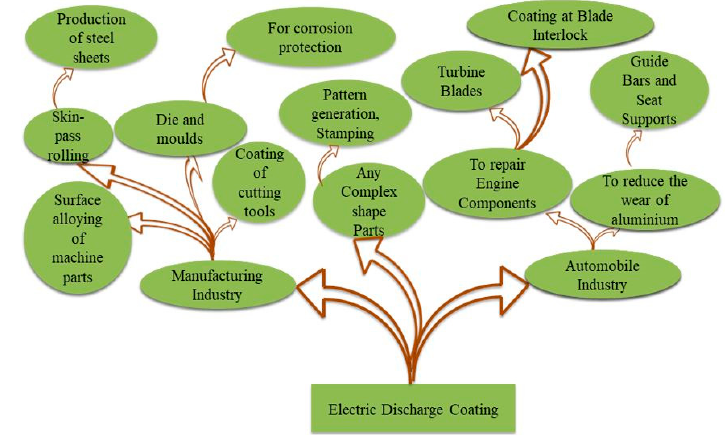
Figure 23. Recent applications of EDC.